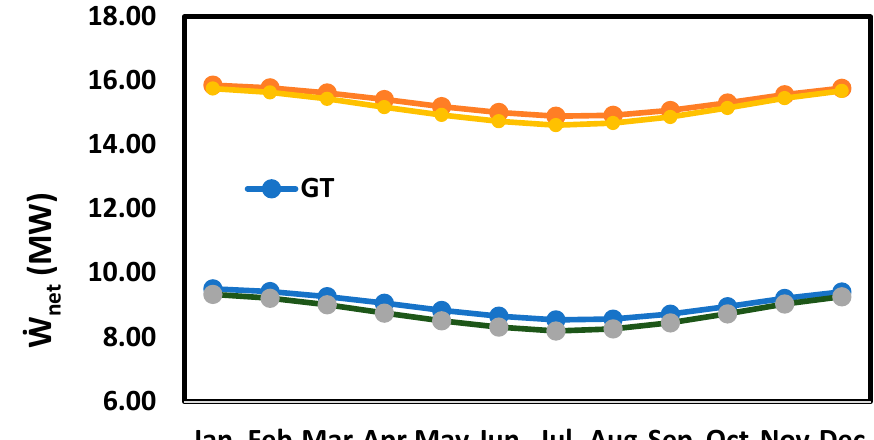
Figure 8. Monthly average of net electricity generation in four types of GT, GT + HRSG, GT + HSR, and GT + HRSG + HSR.